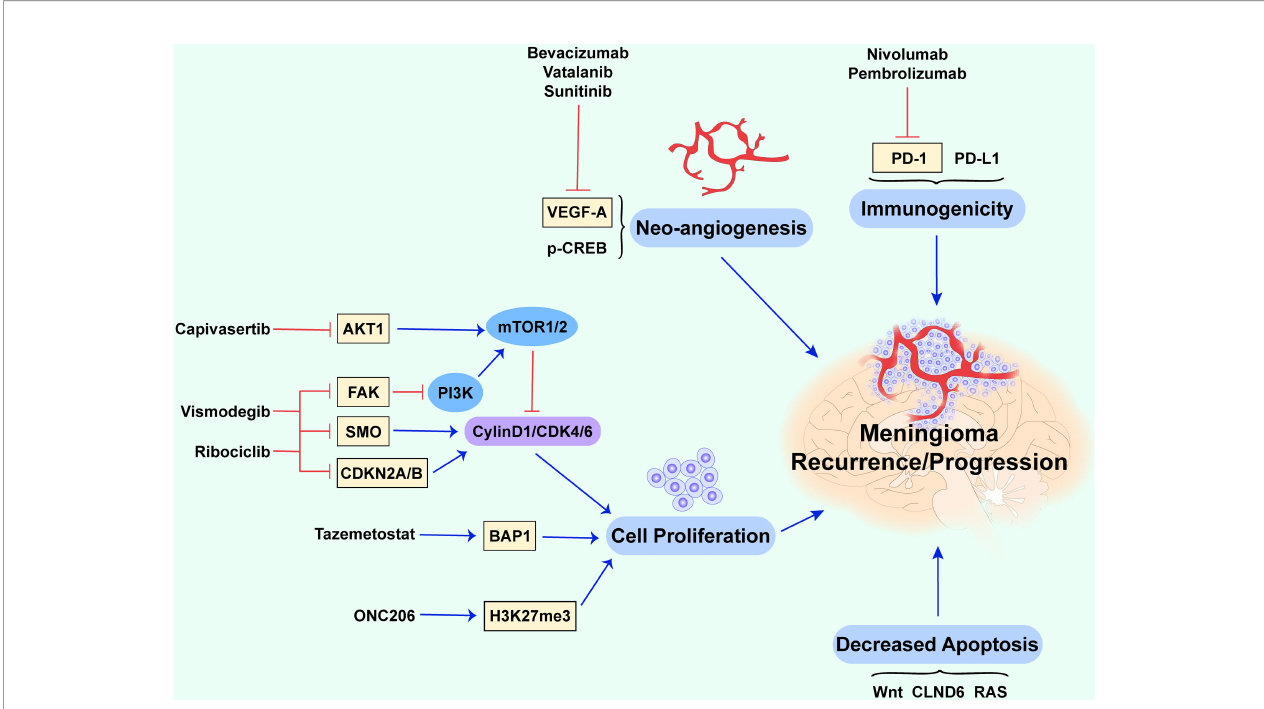
FIGURE 1 | Potential biological mechanisms of recurrent and progressive meningiomas. This fi gure brie fl y summarizes several cellular biological mechanisms and molecules contributing to recurrent and progressive meningiomas. The abnormal proliferation of tumor cells, downregulation of apoptotic processes, neo-angiogenesis, and immunogenicity together promote recurrence and progression (the red lines show an inhibitory effect and the blue arrows show a promoting